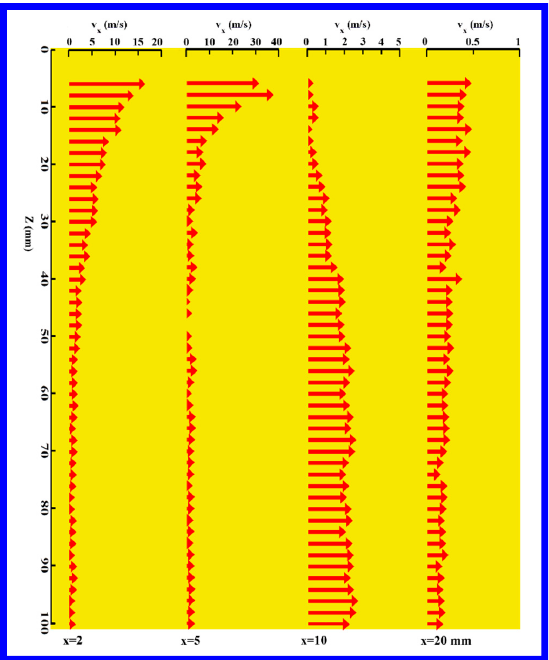
Figure 10. The distribution of lateral velocity, v x , along lines 5–8 of x = 2, 5, 10, and 20 mm, in the corresponding x–z plane.